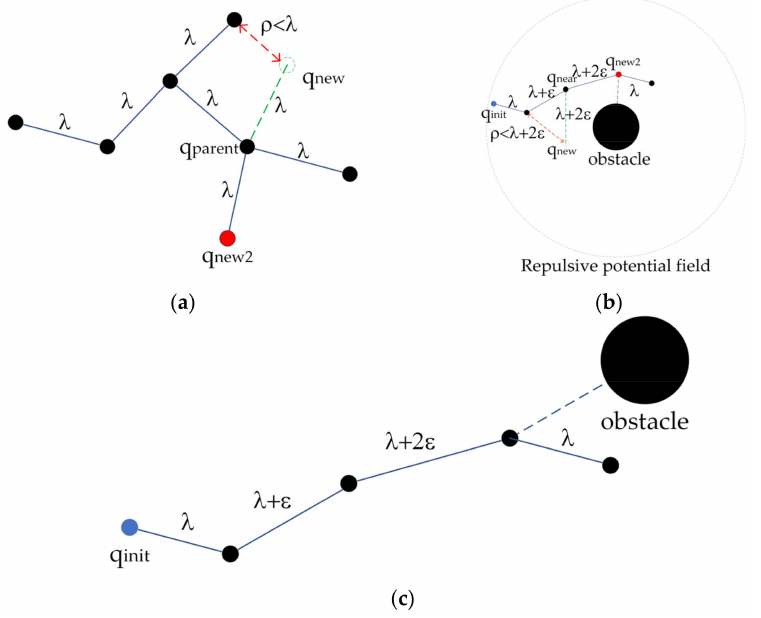
Figure 7. Regression superposition algorithm. ( a ) Regression algorithm; ( b ) Regression superposition algorithm; ( c ) Step-size superposition algorithm. Note: λ , the initial step size; ε , the step size of superposition; ρ , the distance between q new and any